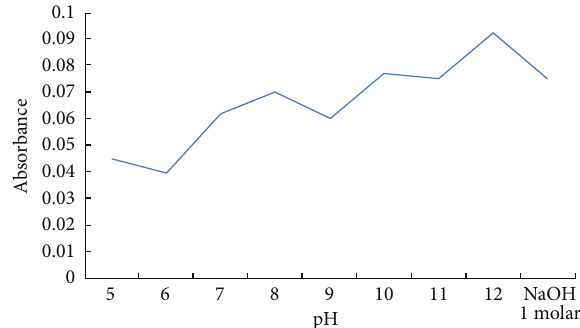
Figure 4: Influence of pH on the absorbance of Cu-MNDTT